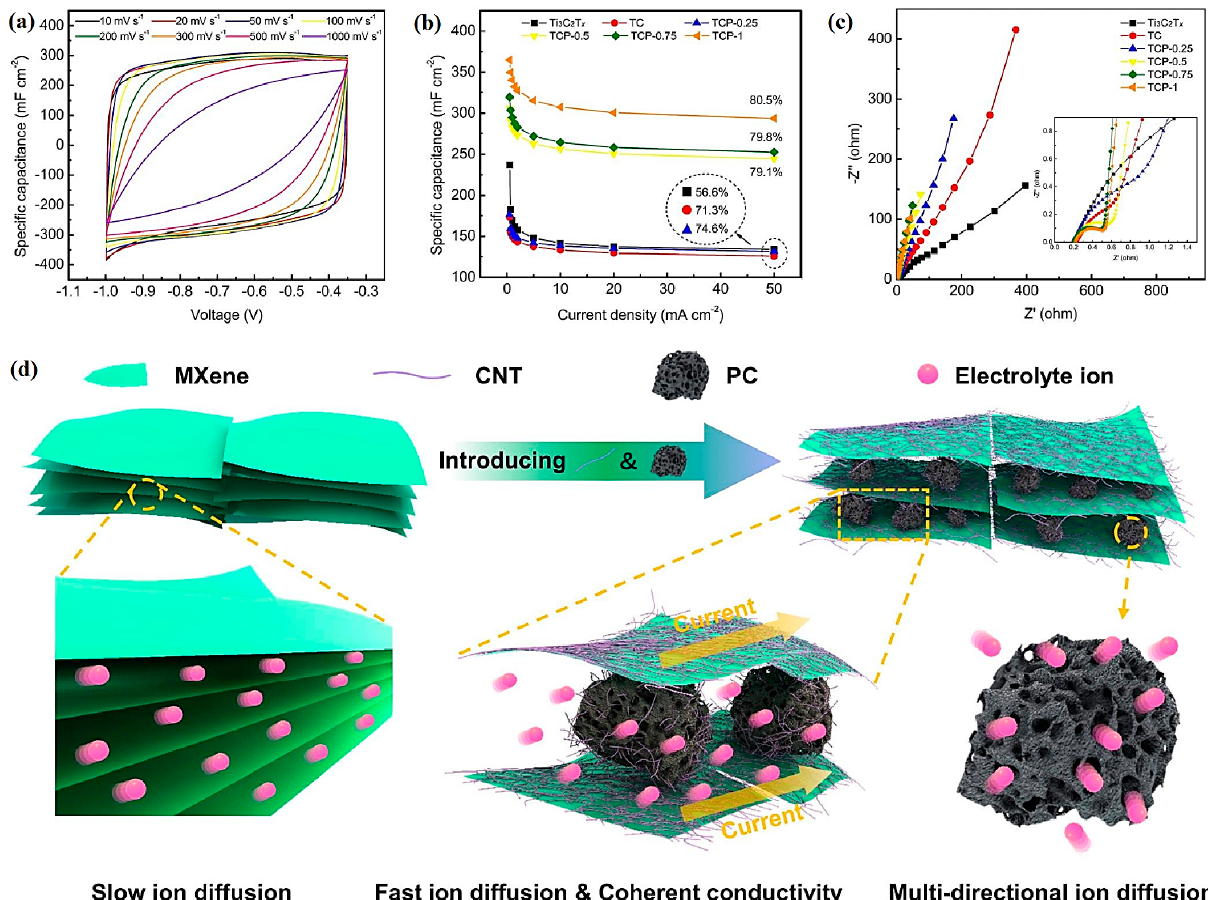
Figure 8. ( a ) Cyclic voltammetry profiles of MXene (Ti 3 C 2 T x )/CNT/porous carbon (TCP) films at various scan rates. ( b ) The rate potentials based on galvanostatic charge–discharge profiles. ( c ) Nyquist plots. ( d ) The ion transport in MXenes and TCP films. PC: porous carbon. Adapted from Ref [116] with permission. Copyright 2021 Elsevier.